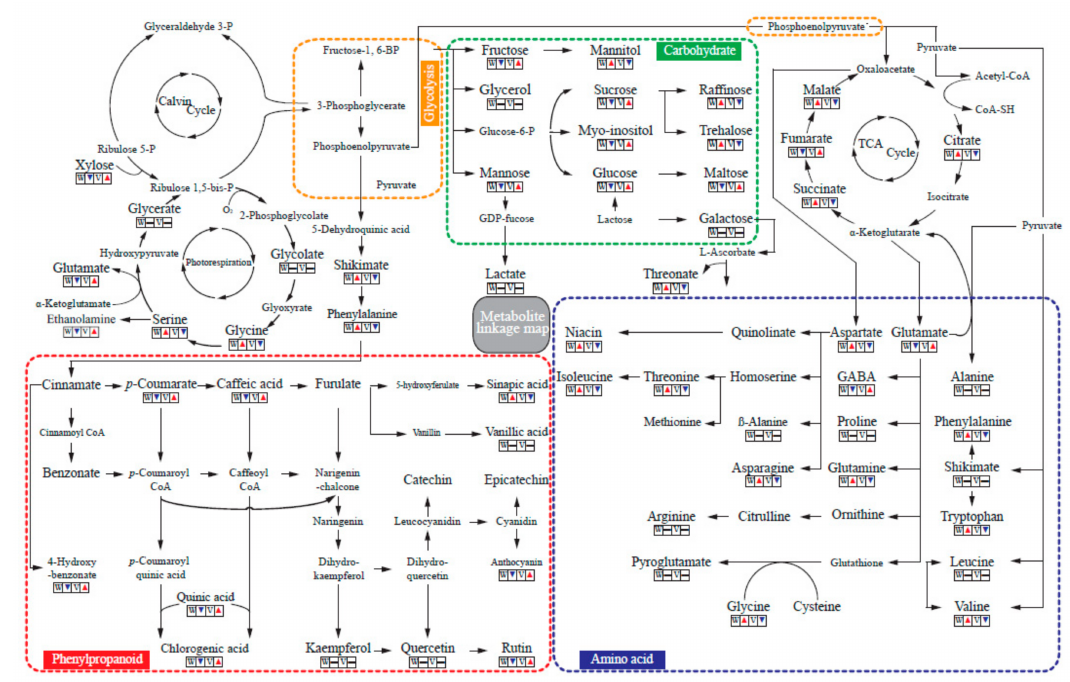
Figure 3. A metabolic linkage map comparing primary and secondary metabolites of white flowers of M. denudata and violet flowers of M. liliiflora . The up arrow ( (cid:78) ) indicates a significantly higher mean value of the metabolite (at p < 0.05). The down arrow ( (cid:72) ) indicates a significantly lower mean value of the metabolite (at p < 0.05). The horizontal bar (–) indicates that no significant difference was found (at p <